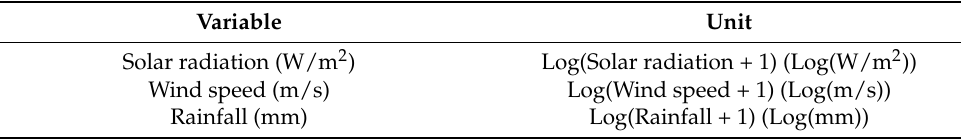
Table 3. Variable transformation. Log indicates the natural